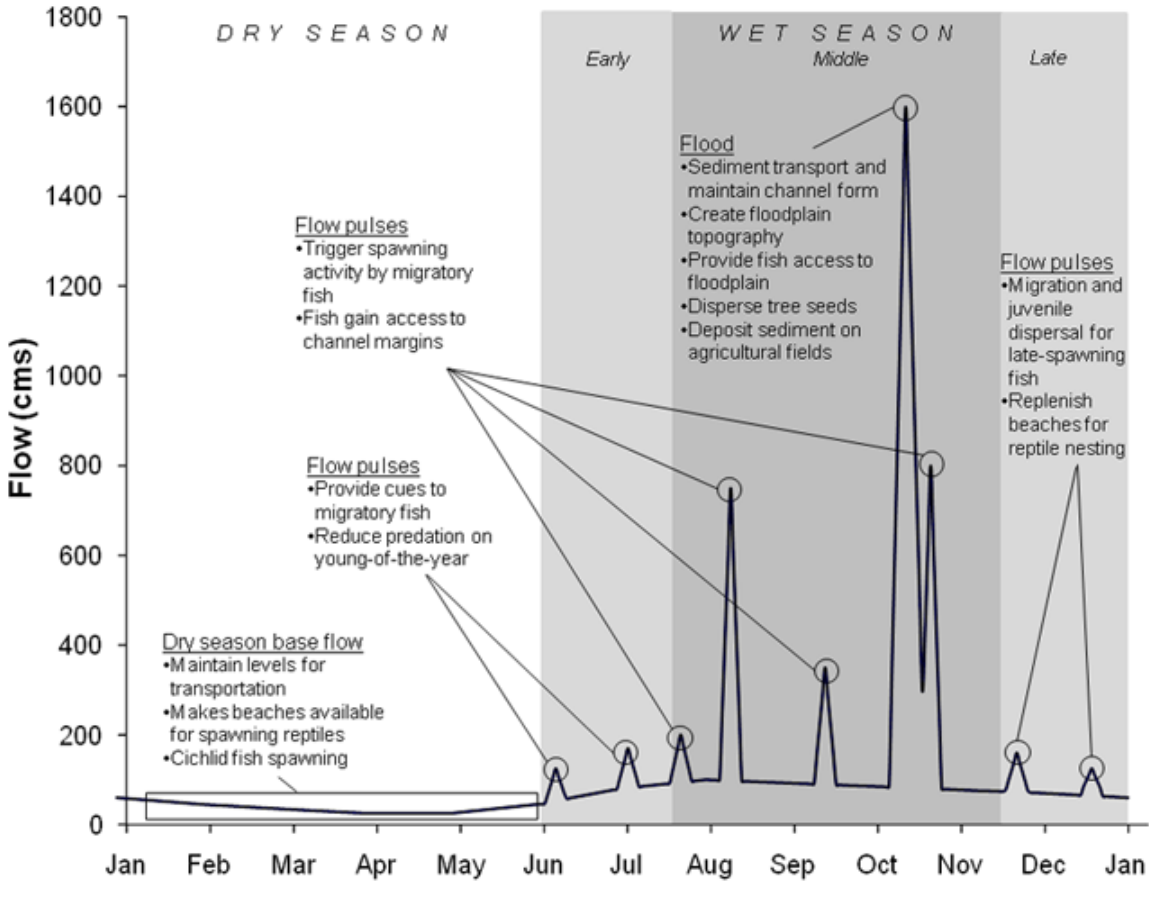
Fig. 6. A graphical summary of our environmental flow recommendation (dark black line) for a “normal” hydrological year. Flow magnitudes are shown on the y-axis, with month shown on the x-axis. Dry and wet seasons are indicated by white and gray shaded areas, respectively. Environmental flow components (base flow, high flow pulses, and floods) are labeled with some details of the important ecological and social values that they support. Ideally, the timing of flow pulses and floods will be adjusted as a function of reservoir inflow, rather than having the static shape presented here as an